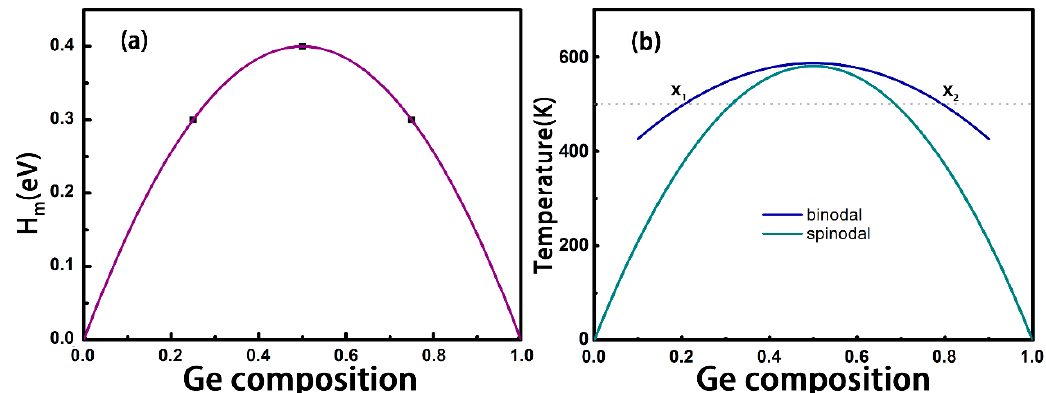
Figure 2. ( a ) Mixing Enthalpy and ( b ) Quasi-binary Phase Diagram as a Function of the Ge Content for the Ge x Sn 1-x Se Alloys. Binodal and Spinodal Curves are Shown in Royal and Dark Cyan Lines in ( b ).